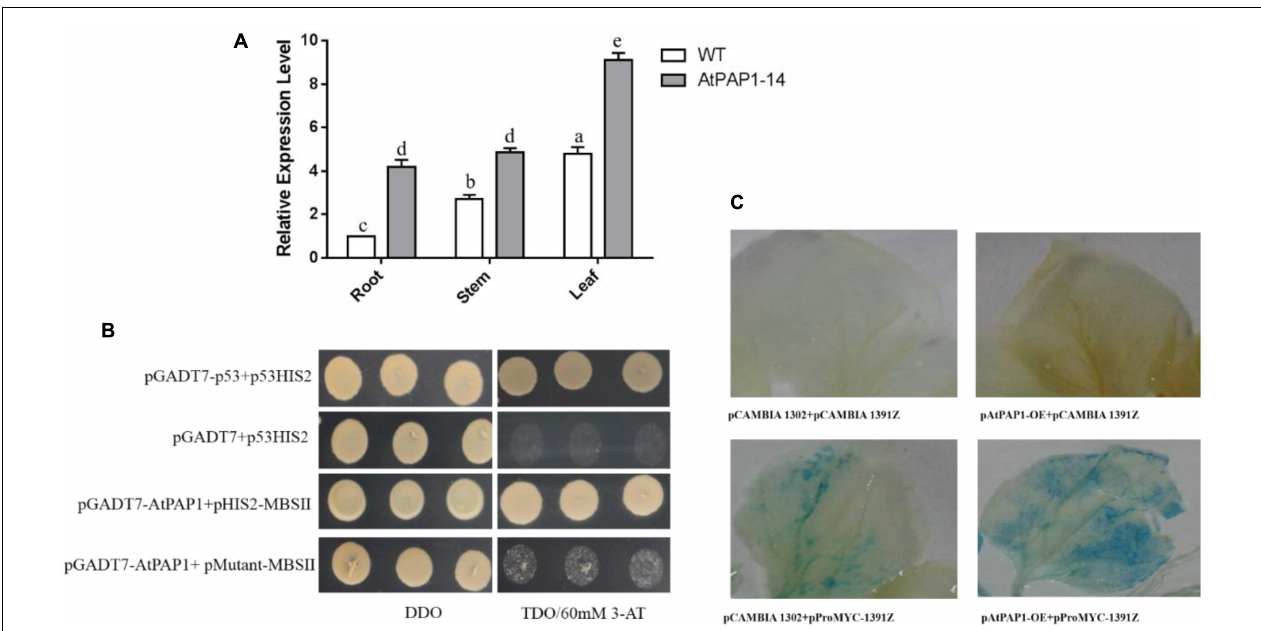
FIGURE 3 | The relationship between AtPAP1 and the SmbHLH51 gene. (A) Relative expression level of SmbHLH51 in AtPAP1-14 and wild type (WT) roots. The results were analyzed using the comparative Ct method and presented as fold changes compared with the WT. The data represent means ± SD of three independent experiments. One-way ANOVA (followed by a Turkey comparison) tested for significant differences among the means (indicated by different letters at p < 0.01). (B) Interaction of AtPAP1 with the MBSII element as revealed by yeast one-hybrid assays. AtPAP1 was fused to GAL4 activation domain (AD). The core sequence of SmbHLH51 promoter MBSII elements were synthesized and cloned into pHIS2 to construct pHIS2-MBSII. Recombinant vectors were co-transformed into yeast strain Y187 and transformed cells were cultured on SD/-Leu/-Trp medium (DDO), then selected on SD/-Leu/-Trp/-His medium (TDO) supplemented with 60 mM 3-amino-1,2,4-triazole (3-AT) to examine protein-DNA interaction. The p53HIS2/pGADT7-p53 and p53HIS2/pGADT7 served as positive control and negative control, respectively. (C) AtPAP1 activates SmbHLH51 promoter via transient expression in tobacco leaves. The effector plasmid pAtPAP1-OE contains AtPAP1 driven by the CaMV 35S promoter. The reporter plasmid pProbHLH51-1391Z contains the GUS reporter gene driven by SmbHLH51 promoter.